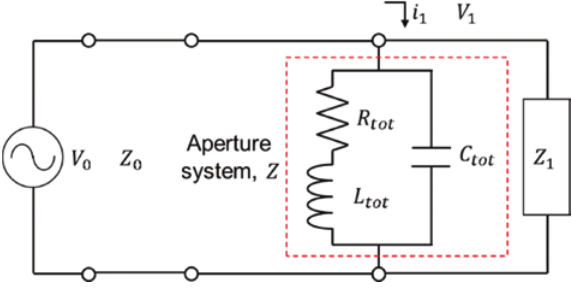
Figure 2: The equivalent electric circuit of an entire ridge nano- aperture system including input and output space. The aperture system highlighted by a red box consists of the resistor-inductor series and the capacitor connected in parallel. The incident wave that comes from the input space (free space) passes through the aperture system into the output